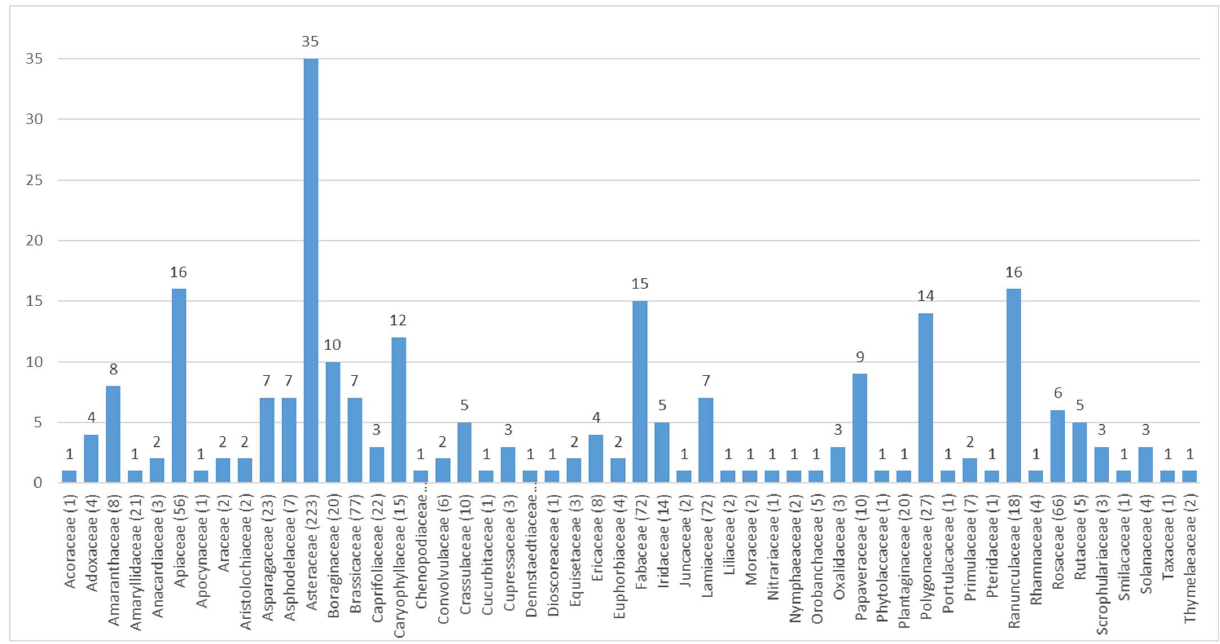
Figure 12. Distribution of toxic taxa of Italian alimurgic flora included in the database AlimurgITA.